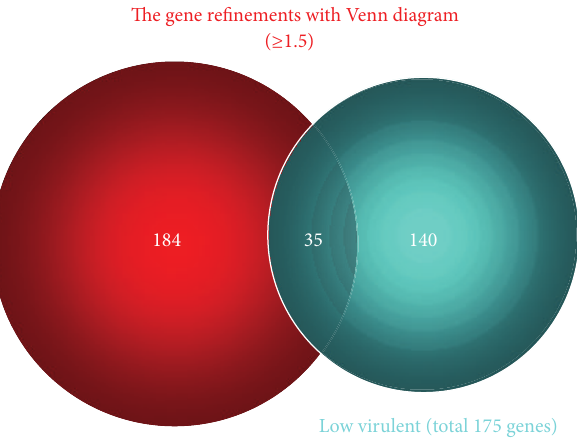
Figure 13: Whereas 219 genes were upregulated in the lungs of mice infected with C. gattii TIMM 4097 (a high-virulence strain), only 175 genes were upregulated in the lungs of mice infected with C. gattii TIMM 4903 (a low-virulence strain). Thus, 35 genes were upregulated in the lungs of mice infected with either C. gattii TIMM 4097 or 4903, while 184 genes were upregulated only in the lungs of mice infected with C. gattii TIMM